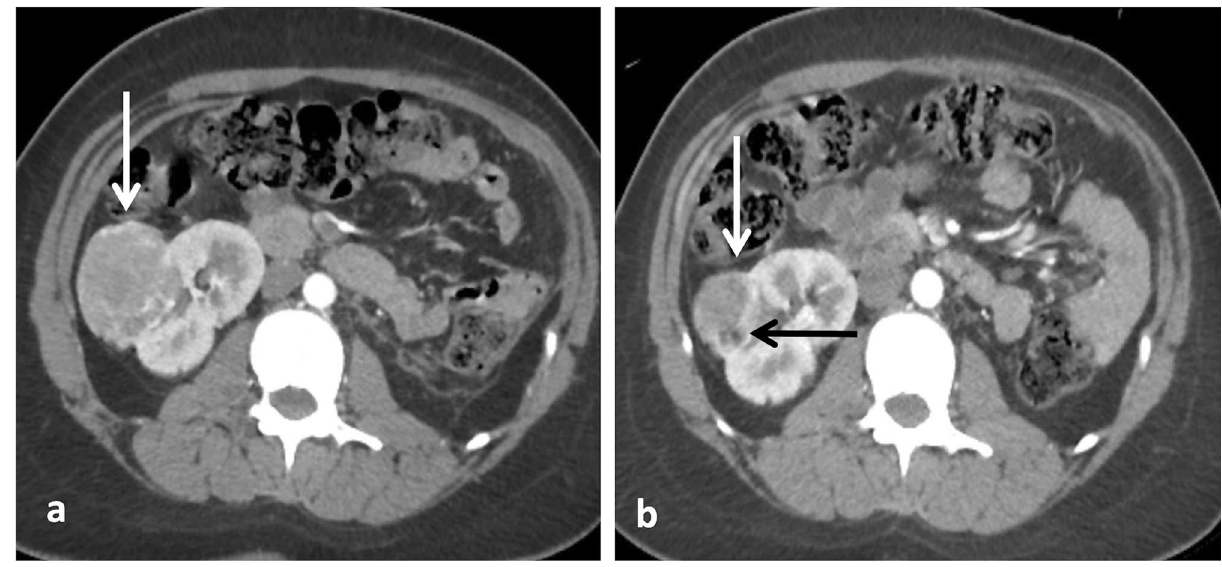
Figure 4. Change in AML volume and fat-containing pattern in response to sirolimus. ( a ) Pre-treatment axial corticomedullary-phase CT scan shows a right renal fat-poor AML (white arrow). ( b ) Post-treatment axial corticomedullary-phase CT image reveals tumor volume reduction (white arrow) while the fat component becomes visible (black arrow). Note that the AML total volume reduction (from 76.4 cm 3 to 26.9 cm 3 ) occurred due to diminishment of the fat-poor (from 60.1 cm 3 to 13.0 cm 3 ) and highly-vascularized (from 15.4 cm 3 to 11.3 cm 3 ) compartments.